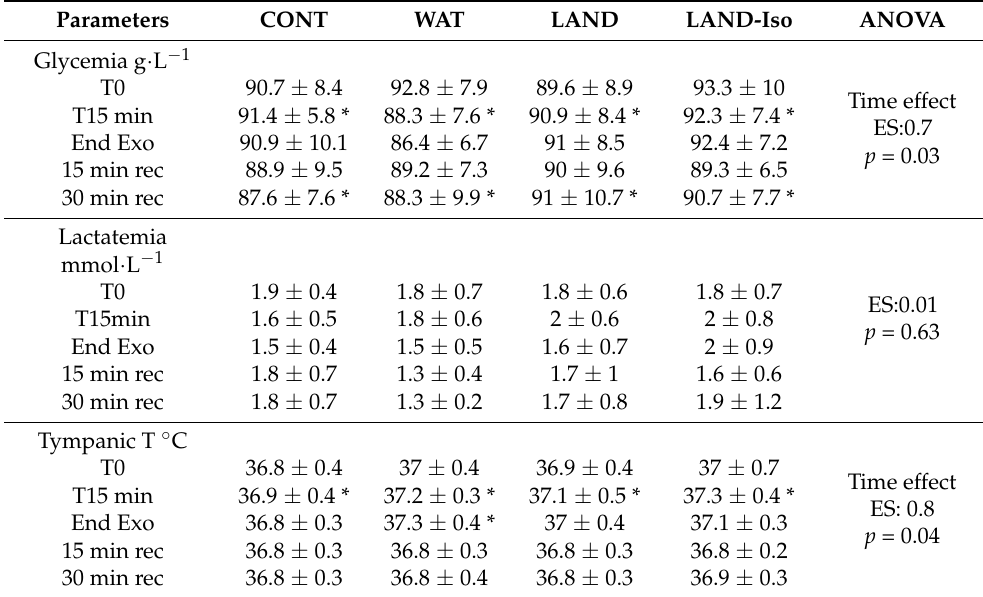
Table 3. Blood parameters and tympanic temperature during sessions and